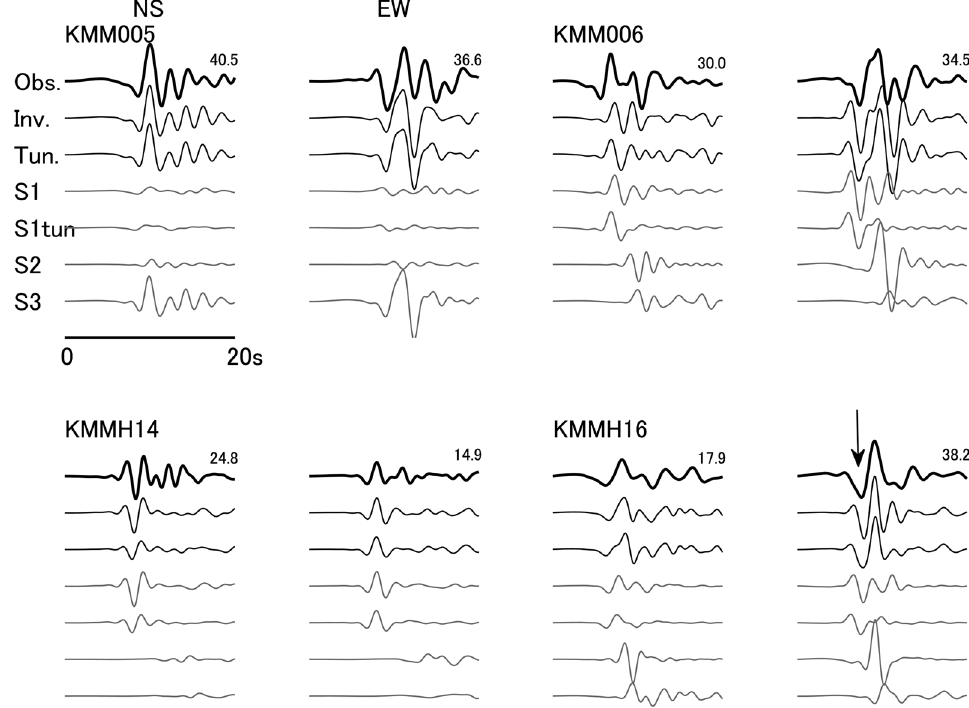
Fig. 9 Comparison of the observed (thick), synthetic (thin) and SMGA (gray) velocity waveforms at target sites for the models in Table 4 and Fig. 8, with a period range 1.5–10 s. The second waveform is for inverted model, and third waveform is for the moment-tuned model for SMGA1. Waveforms labeled “S1”, “S2” and “S3” are, respectively, for SMGA1, SMGA2 and SMGA3 of inverted model. Waveforms labeled “S1tun” are for SMGA1 of tuned model. Arrow indicates the westward pulse at